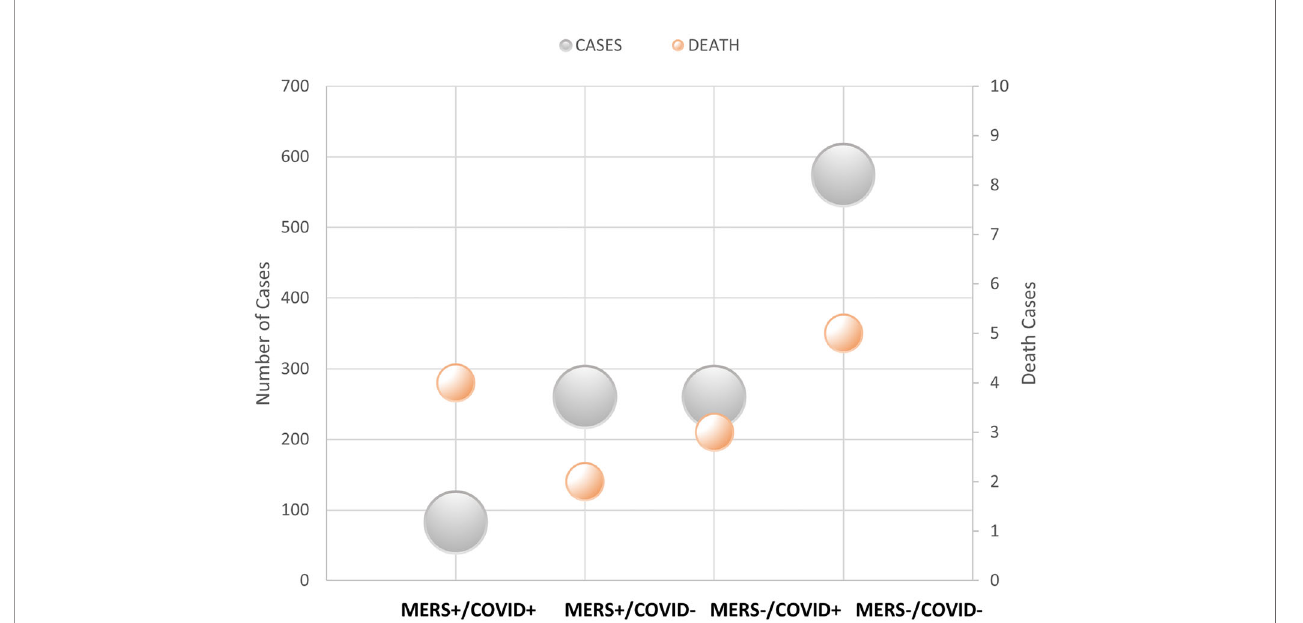
FIGURE 3 | Number of cases and deaths based on MERS and COVID-19 infection.